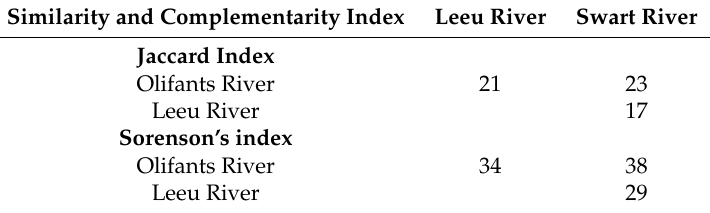
Table 2. The Jaccard’s and Sorenson’s coe ffi cients of similarity between the Leeu, Olifants, and Swart riparian zones, expressed as percentages.